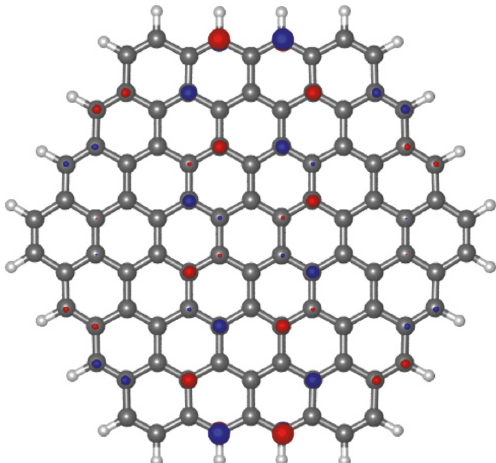
Figure 9: H 4 HOMO 1.